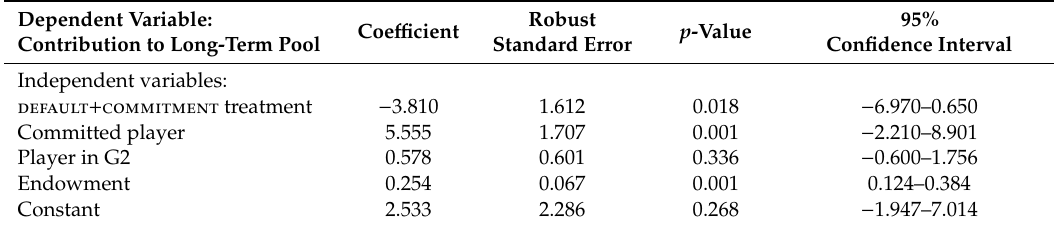
Table A1. Comparison of the default and the default+commitment treatment.